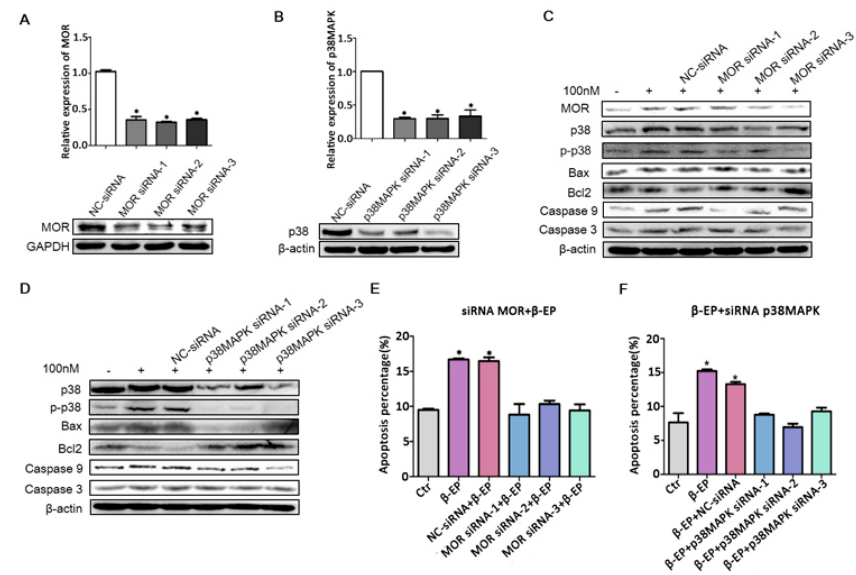
Figure 6. Contribution of the β -EP − MOR − p38 MAPK − Bax − caspase 3 pathway to LC apoptosis. Transfection of TM3 cells with si-MOR ( A ) or si-p38 MAPK ( B ) reduced the target gene expression level relative to a control gene ( β -actin or GAPDH) as assessed by qRT-PCR and western blotting. ( C , D ) Elevated expression levels of MOR, p38 MAPK, Bax, Bcl-2, caspase 9, and caspase 3 in response to β -EP (100 nM) were reduced by si-MOR or si-p38 MAPK transfection but not by a negative control siRNA. Increasing TM3 cell apoptosis by β -EP was reversed by transfection with si-MOR ( E ) or si-p38 MAPK ( F ).